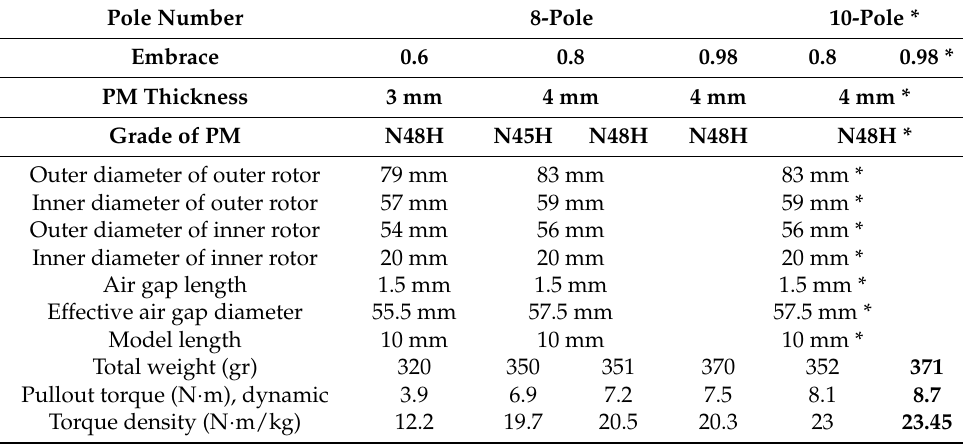
Table 3. Dimension and performance list of various MCs in summary.